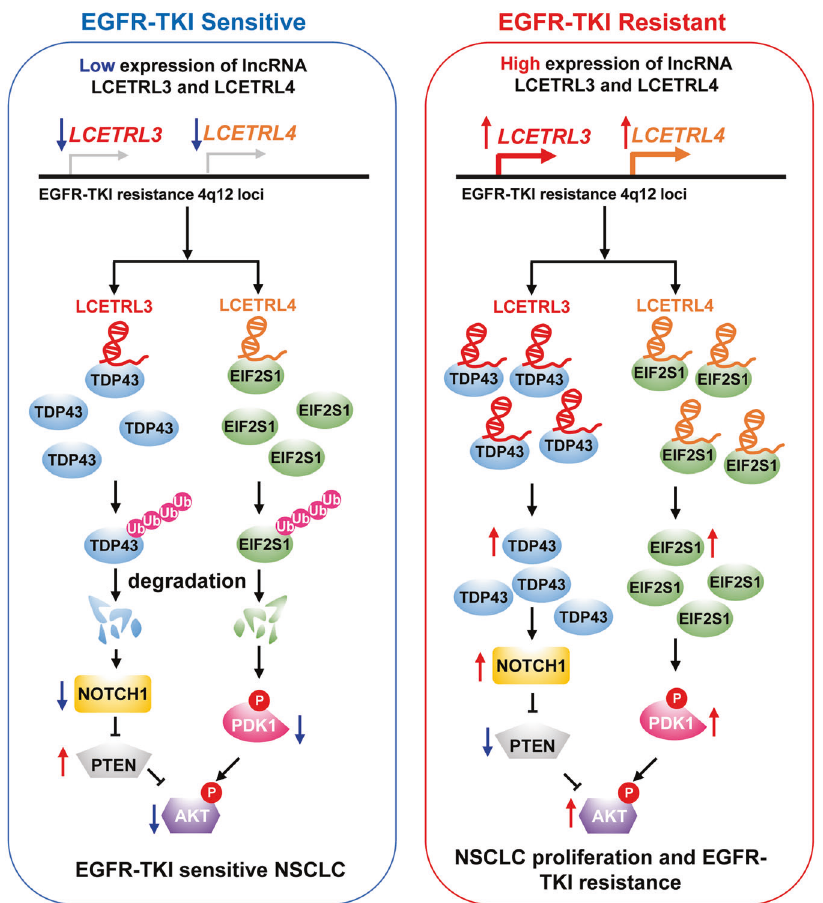
Fig. 6 Graphical representation of the oncogenic functions of lncRNA LCETRL3 or LCETRL4 in EGFR-TKIs treatment of NSCLC. In EGFR-TKIs sensitive cells, low levels of lncRNA LCETRL3 or LCETRL4 cause deactivation of the AKT signaling in NSCLC. However, high levels of LCETRL3 or LCETRL4 could stabilize and upregulate oncoproteins TDP43 or EIF2S1, increase levels of NOTCH1 or phosphorylated PDK1, activate the AKT signaling and, thus, result in EGFR-TKIs resistance of NSCLC